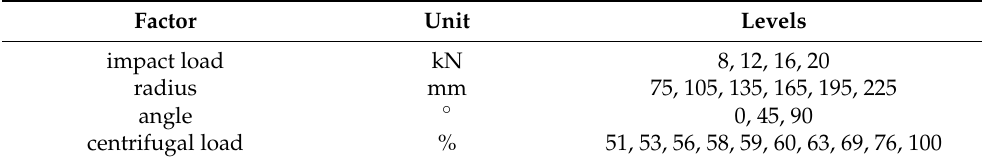
Table 1. All factors that are used for the simulation with unit and levels of the factors.